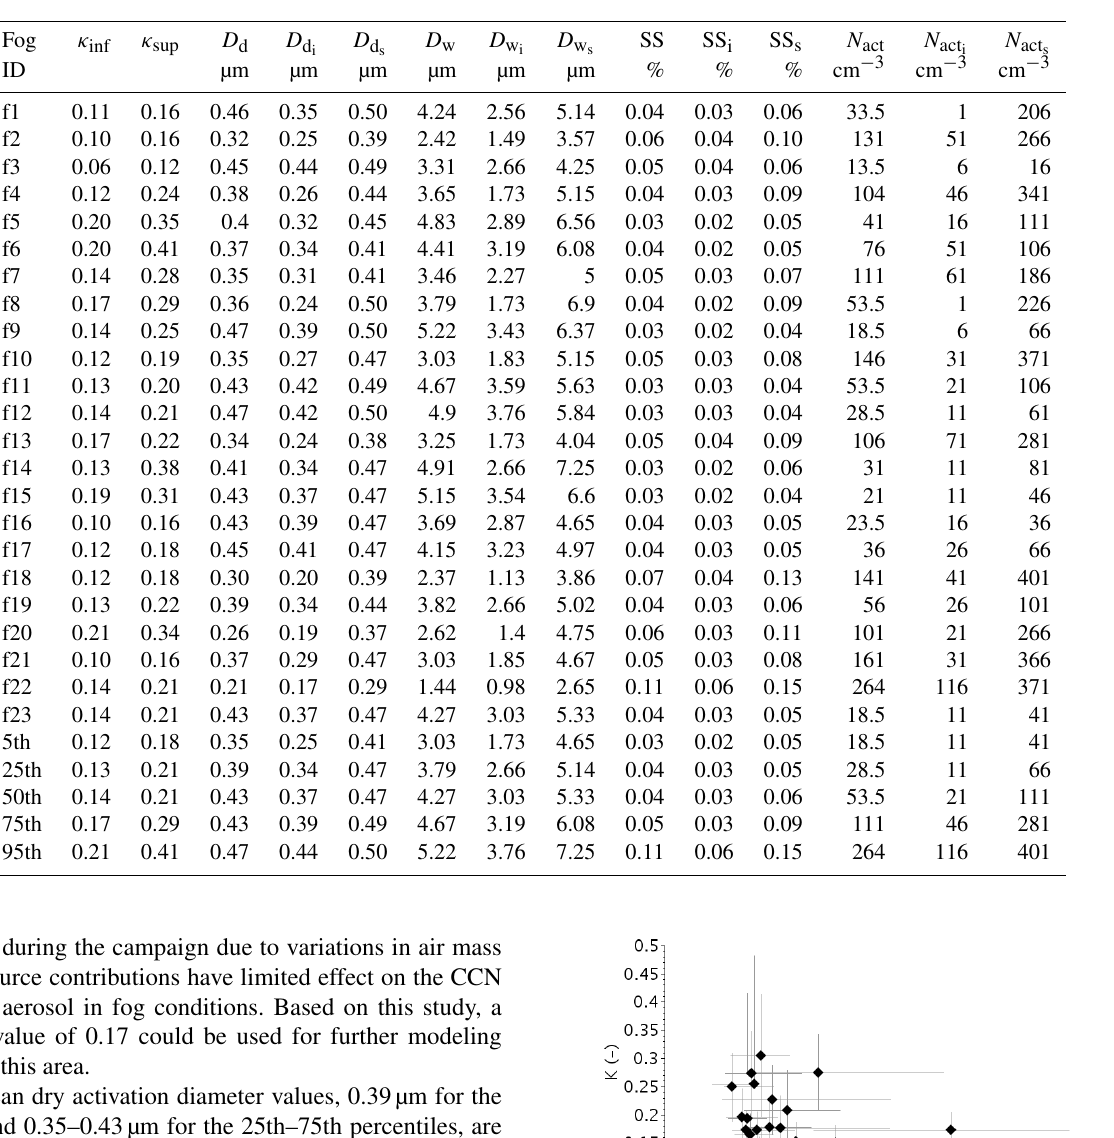
Table 3. Activation properties of the 23 fog events: hygroscopicity parameters κ inf and κ sup , mean values and uncertainty intervals of the dry diameter D d , the wet diameter D w , the supersaturation SS peak and the number concentration of activated particles N act . The 5th, 25th, 50th, 75th and 95th percentiles of the distribution of the 23 cases are indicated on the last lines for each parameter.